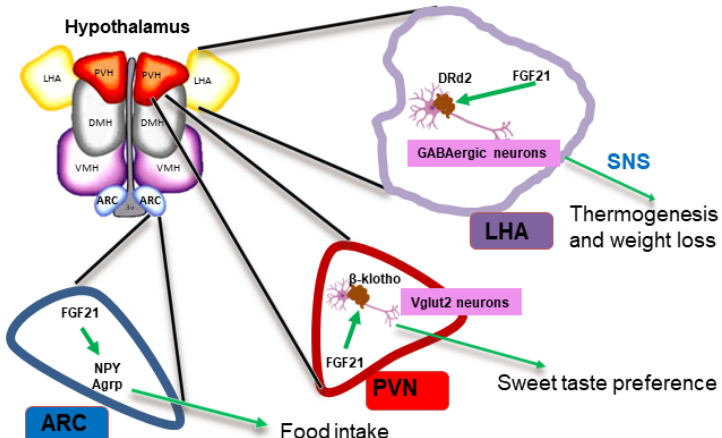
Figure 3. Description of the metabolic actions elicited by FGF21 in the hypothalamus. FGF21. FGF21 is a hepatic signal that induces food intake and improves several metabolic parameters such as energy expenditure, BAT thermogenesis, mainly by its action in the hypothalamus. CNS.